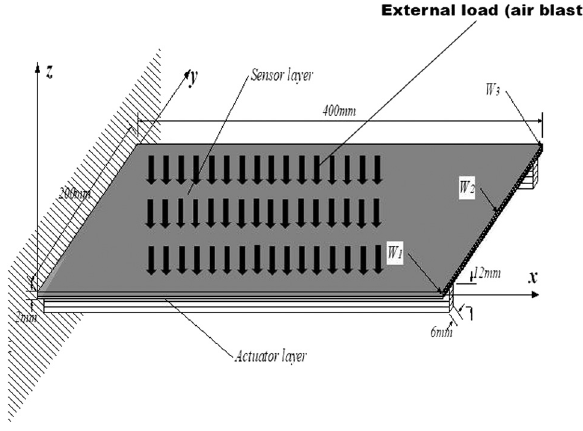
Figure 2: Cantilevered composite plate with two shear webs, piezoelectric sensors and